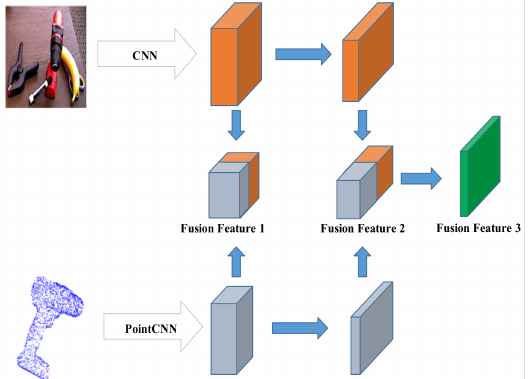
Figure 4. Schematic diagram of the feature fusion algorithm. Three red boxes can be obtained to represent the feature fusion of the three stages, and the final global feature can be obtained by combining these three